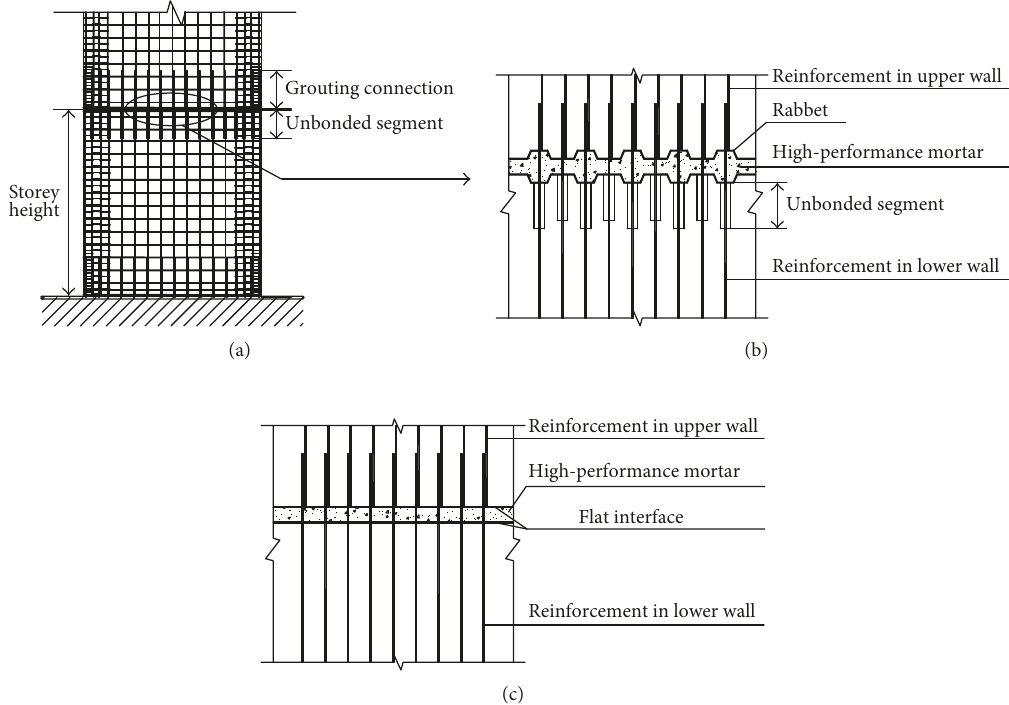
Figure 1: (a) Prefabricated shear wall, (b) the RHC details, and (c) conventional connection details. Note: For the sake of clarity, the lateral web reinforcements in the upper and lower walls are not shown in (b) and